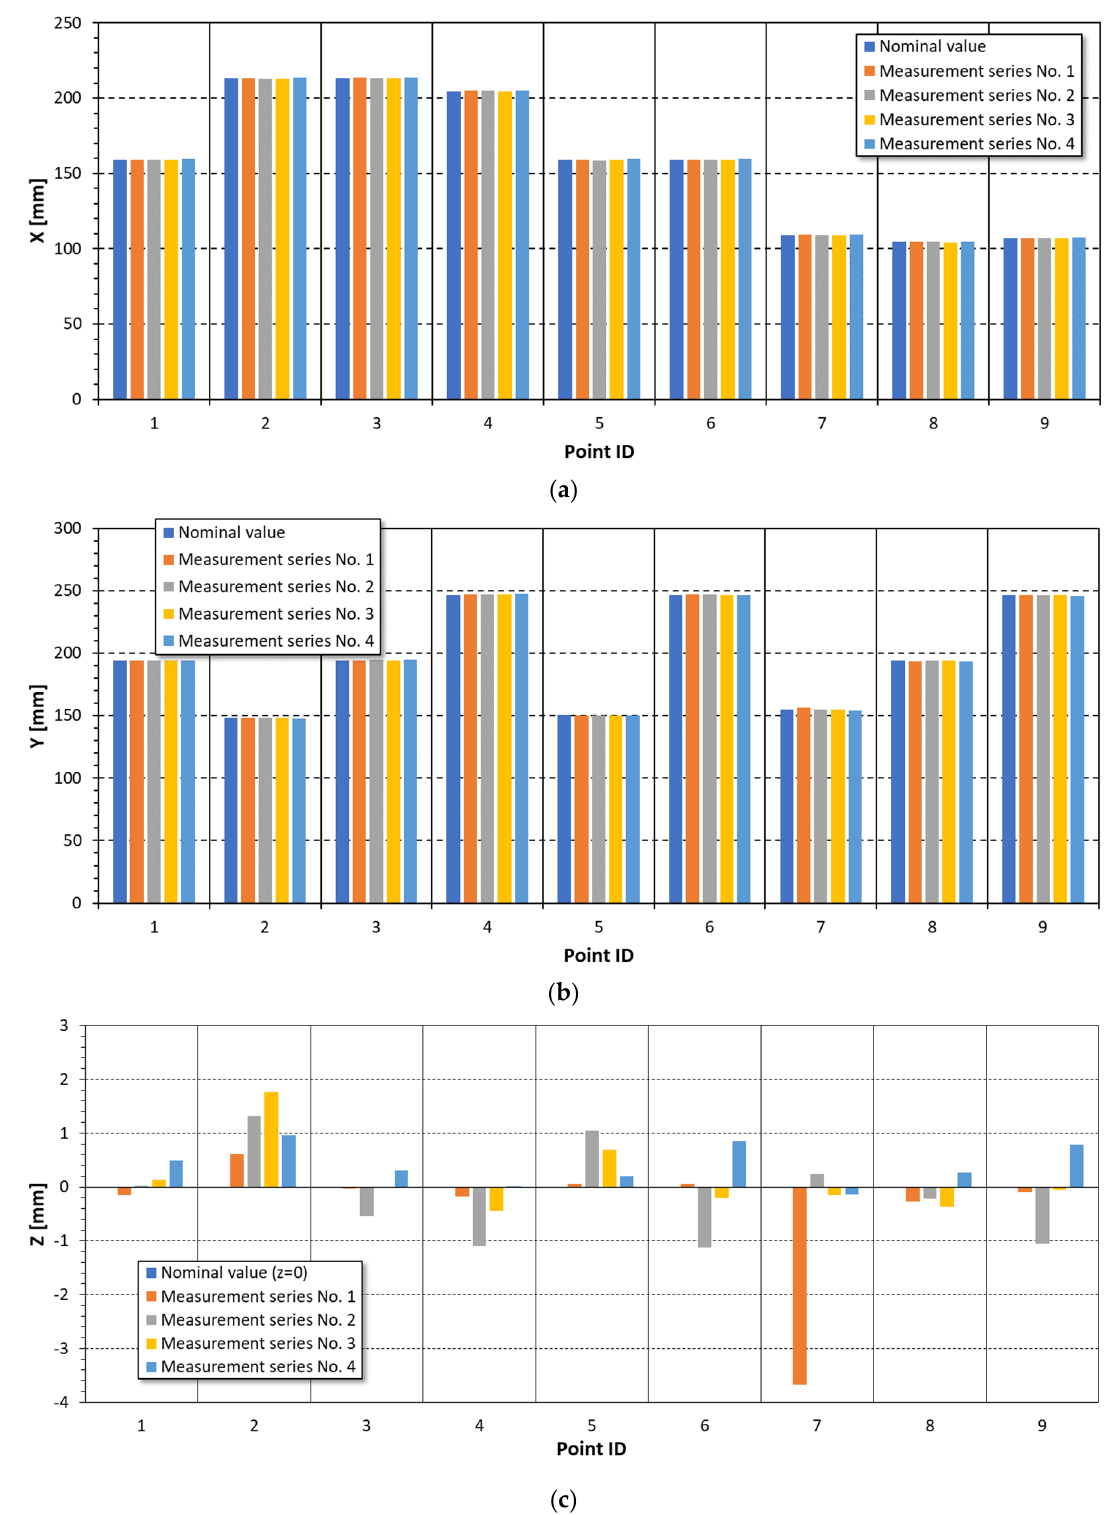
Figure 14. Comparison of the values of coordinates of nine measurement points obtained in four measurement series against nominal values of the model for parameters obtained from minimization of the objective function F 2 : ( a ) X coordinate, ( b ) Y coordinate, ( c ) Z coordinate. For the thus determined set of parameters related to the transformation of the robot tool coordinate system to the left camera position of the considered measurement system, the spatial position of all points of the laser pattern grid recorded in the acquired photo-